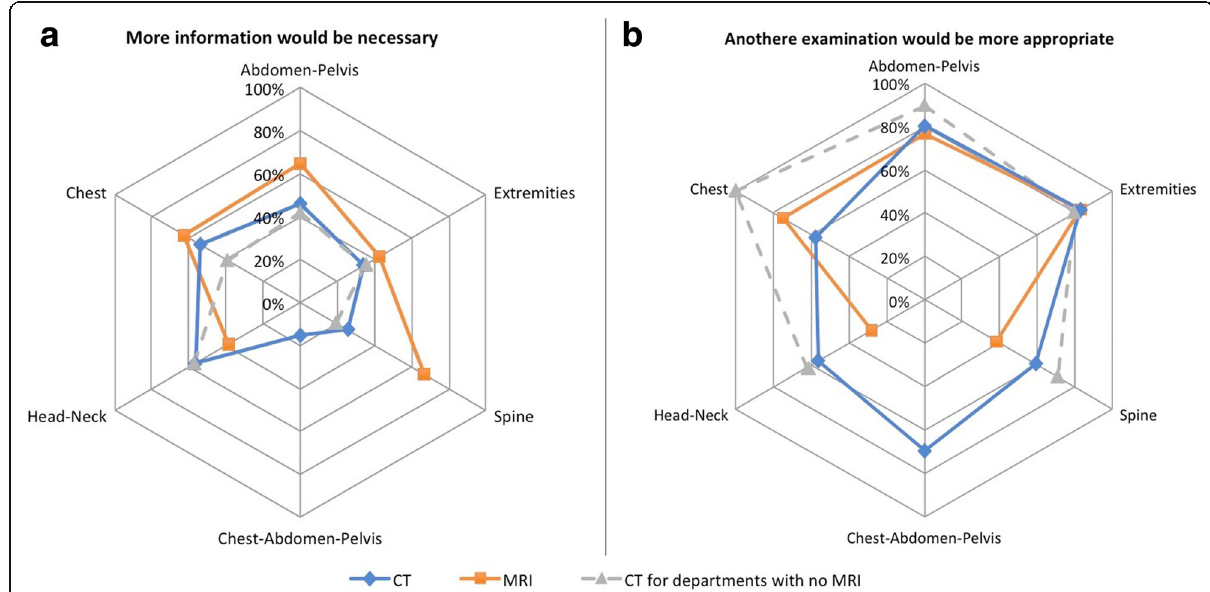
Fig. 4 a Radar chart showing for each anatomical area the proportion of inappropriate requests for which more information would be necessary: for CT requests, for MRI requests and for CT requests for the two radiology departments not equipped with MRI units. b Radar chart showing for each anatomical area the proportion of inappropriate requests for which another examination would be more appropriate: for CT requests, for MRI requests and for CT requests for the two radiology departments equipped with only CT